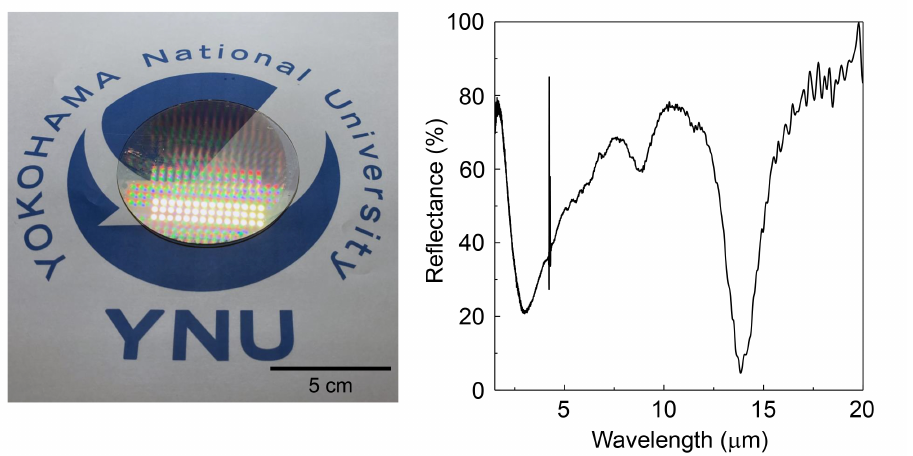
Figure 6. Radiative cooling. Large area fabrication of transparent metasurfaces on a 3-inch diameter MIM (ITO/CaF 2 /Au-micro discs) wafer and its reflectance R spectrum. The ∼ 80% dip in R at ∼ 13 µ m is engineered using MIM metasurface fabricated by a simplified photo-lithography approach. Such a window will facilitate radiative heat removal out of the room into air ambient outside. At the visible spectral range, such a window is reflective (see a daylight lamp reflection in the photo). Structure of MIM-wafer: on soda-lime glass, 180 nm of ITO base-layer, CaF 2 insulator (200 nm), and Au micro-discs on top (50 nm thickness); 2 nm of Cr was used as an adhesion layer.